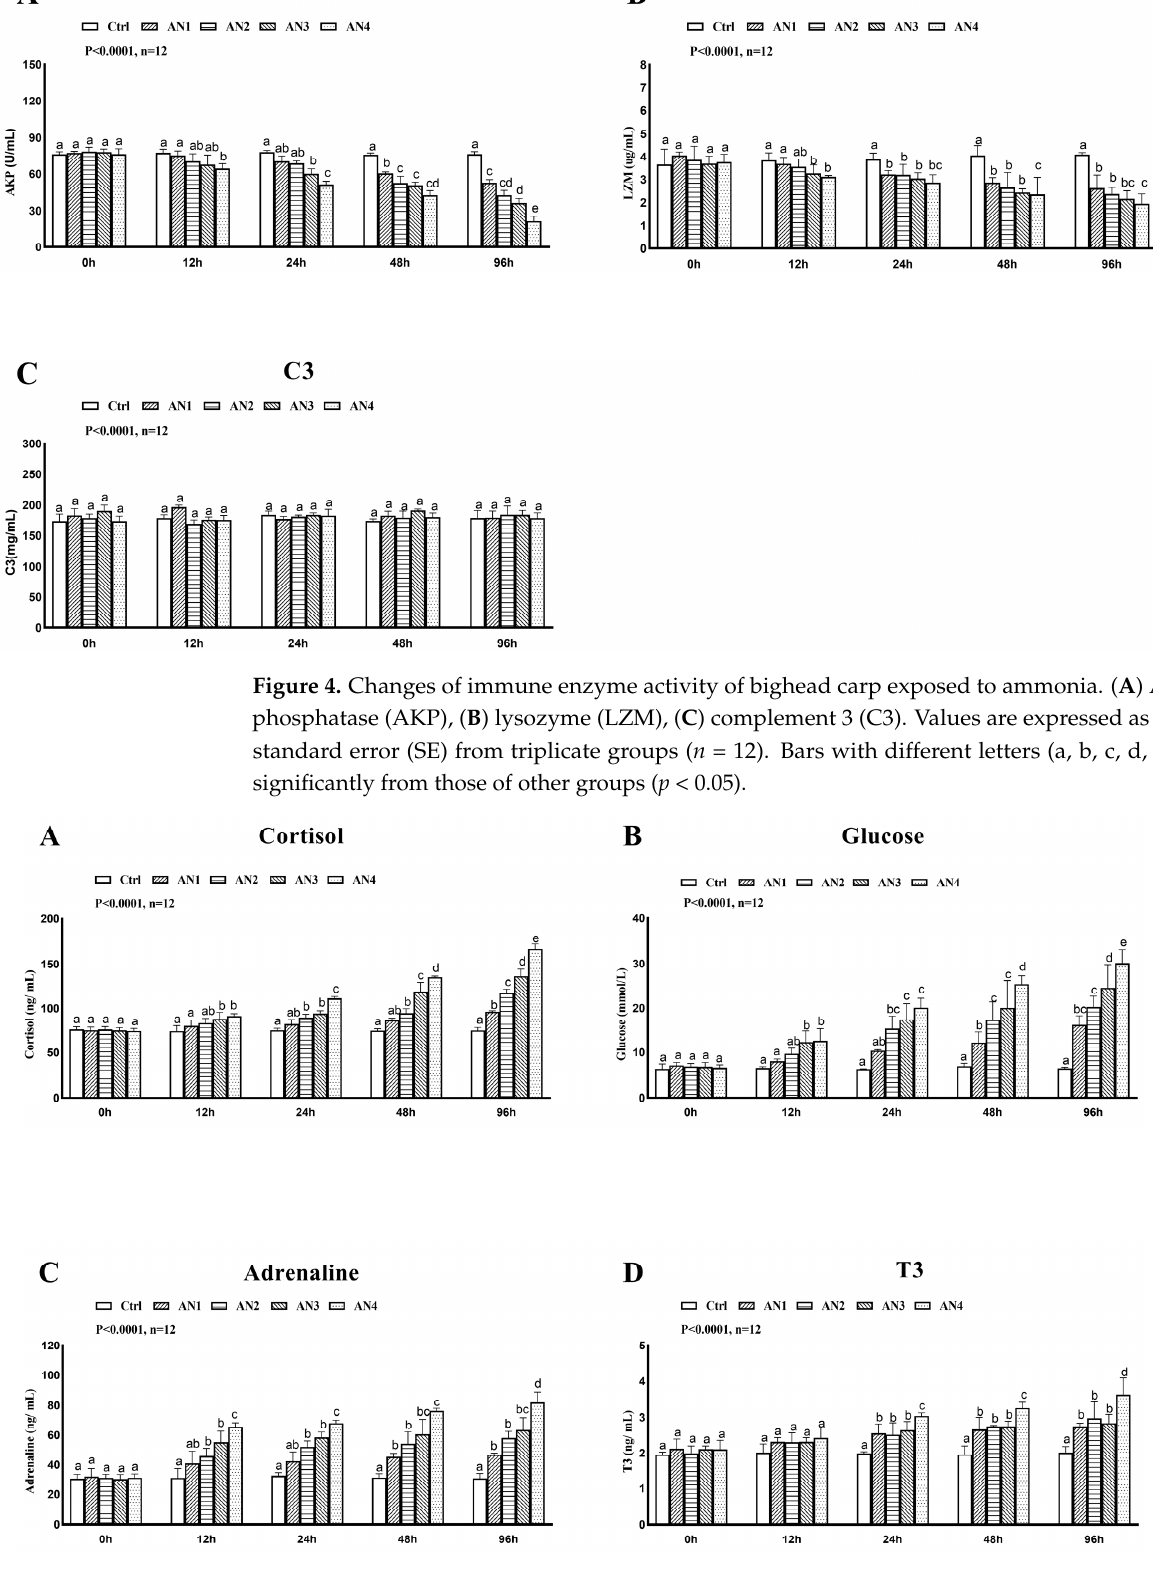
Figure 5. Changes of stress-related hormones in bighead carp exposed to ammonia. ( A ) Plasma cortisol, ( B ) glucose (Glu), ( C ) adrenaline, and ( D ) 3 ′ -triiodothyronine (T3). Values are expressed as mean ± standard error (SE) from triplicate groups ( n = 12). Bars with different letters (a, b, c, d, e) differ significantly from those of other groups ( p < 0.05).